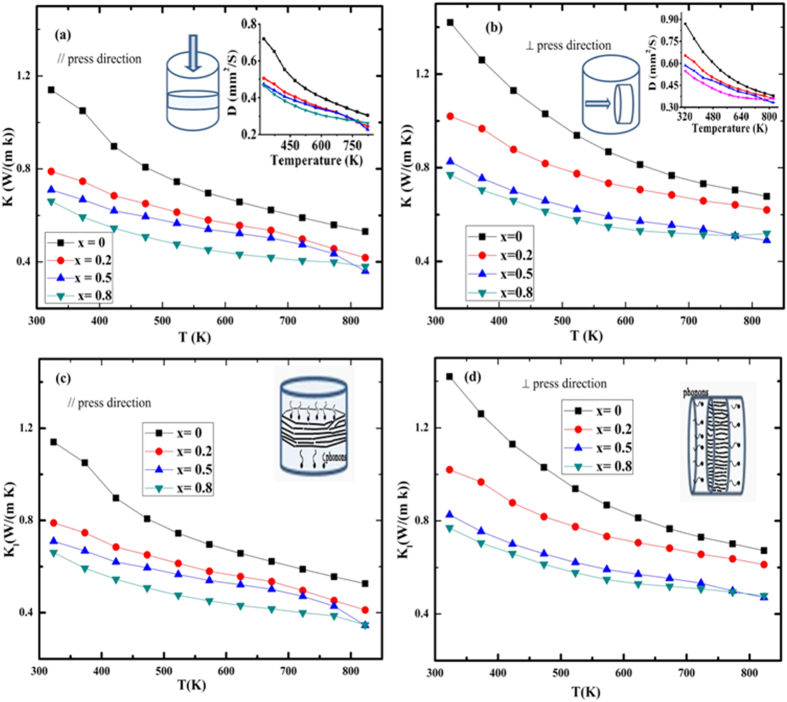
Temperature dependence of the total thermal conductivity (the inset shows the thermal diffusivity) of the SnS1−xSex (x = 0, 0.2, 0.5, 0.8) solid solutions (a) parallel (//) and (b) perpendicular (⊥) to the SPS–pressurizing direction. The lattice thermal conductivity of the SnS1−xSex solid solution (c) parallel (//) and (d) perpendicular (⊥) to the SPS–pressurizing direction.